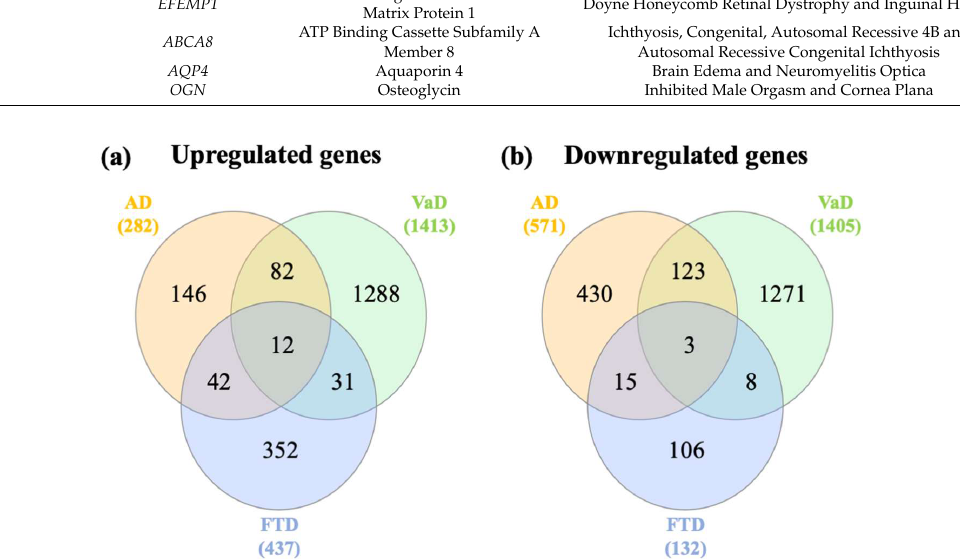
Figure 2. Venn diagram analysis of differentially expressed genes. ( a ) Venn diagram analysis of upregulated genes in AD, VaD, and FTD. ( b ) Venn diagram analysis of downregulated genes in AD, VaD, and FTD. The genes in the AD group represent the genes identified in the meta-analysis of AD datasets. AD